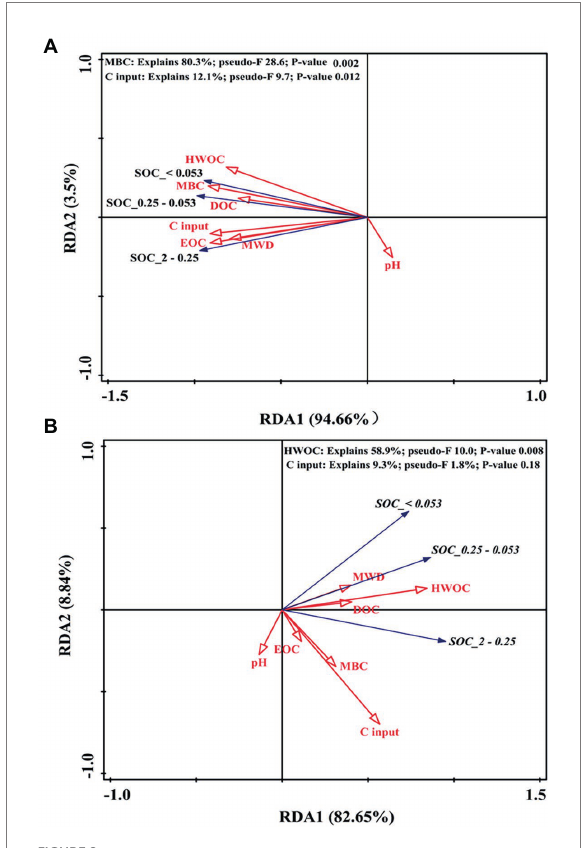
FIGURE 8 RDA plot showing the associations between the SOC content in soil aggregate fractions and different pools of organic C (MBC, DOC, HWOC, and EOC), C input, pH, and MWD at depths of 0–10 cm (A) and 10–20 cm (B) . MBC: microbial biomass carbon; DOC: dissolved organic C; HWOC: hot water organic C; EOC: easily oxidized C; MWD: mean weight